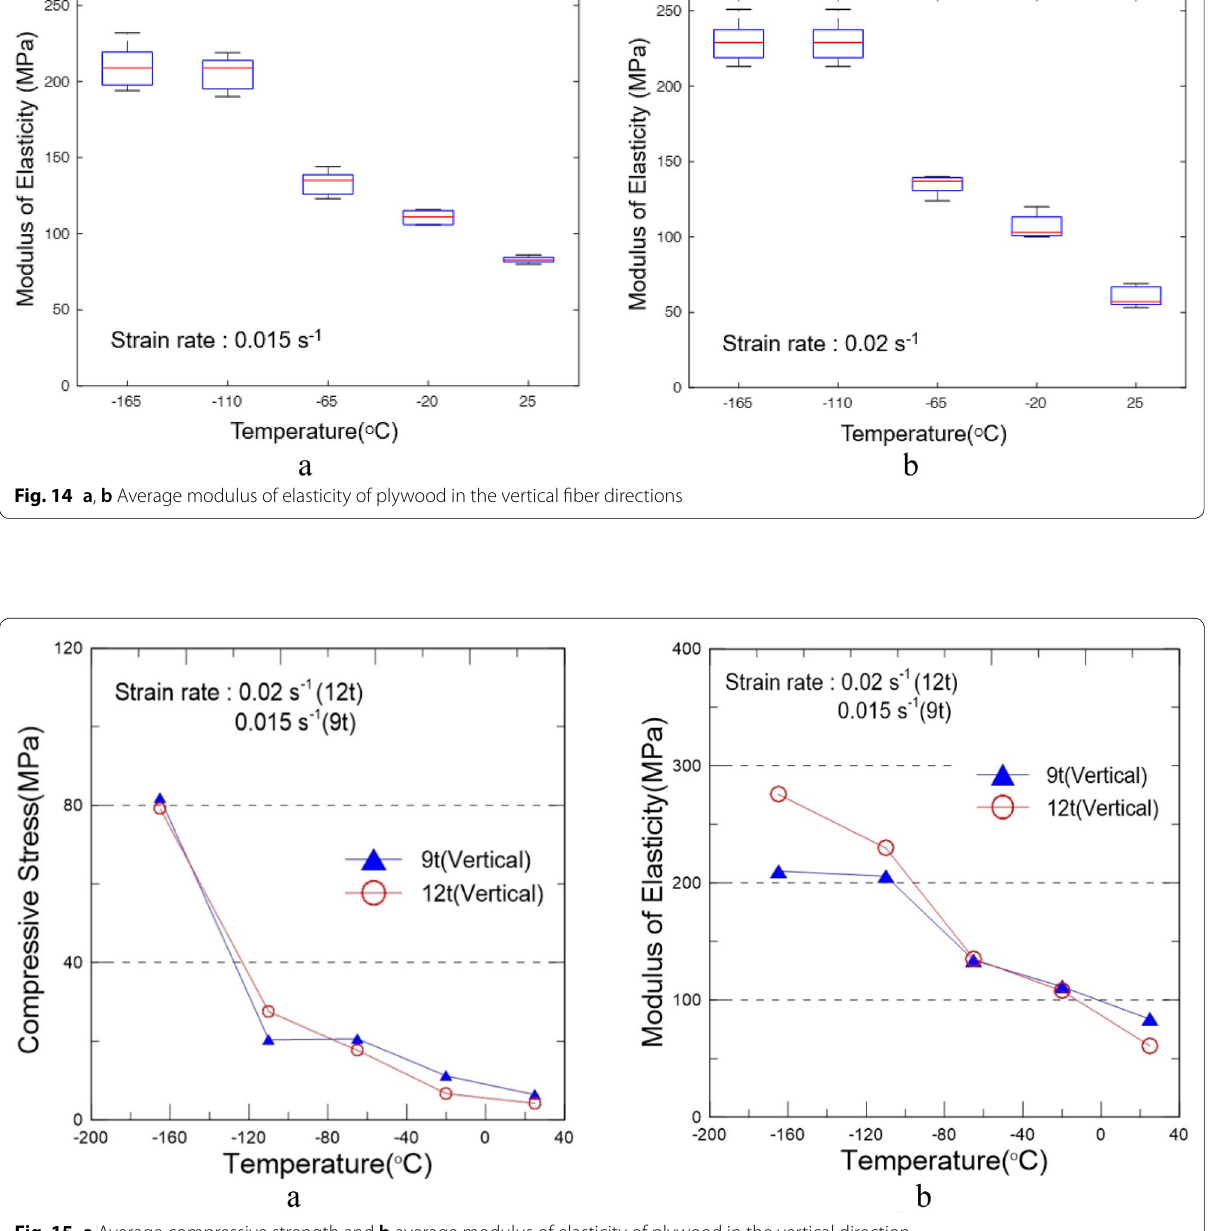
and delamination (Fig. 17b). This leads to an interfa- The mechanical properties of plywood such as ductility cial crack in the adjacent layer at 165 °C, as shown in − and brittleness were confirmed from the stress–strain Fig. 17c. It can be said that the phenomenon of micro- curves shown in Fig. 7. Based on this, the ultimate crack and interfacial crack formation is a major issue in strain of plywood was determined, and is shown in LNG CCSs along with the risk of cryogenic liquid spill- Fig. 18. In the present study, the fracture characteristics age that can cause the fracture of sandwich structures.